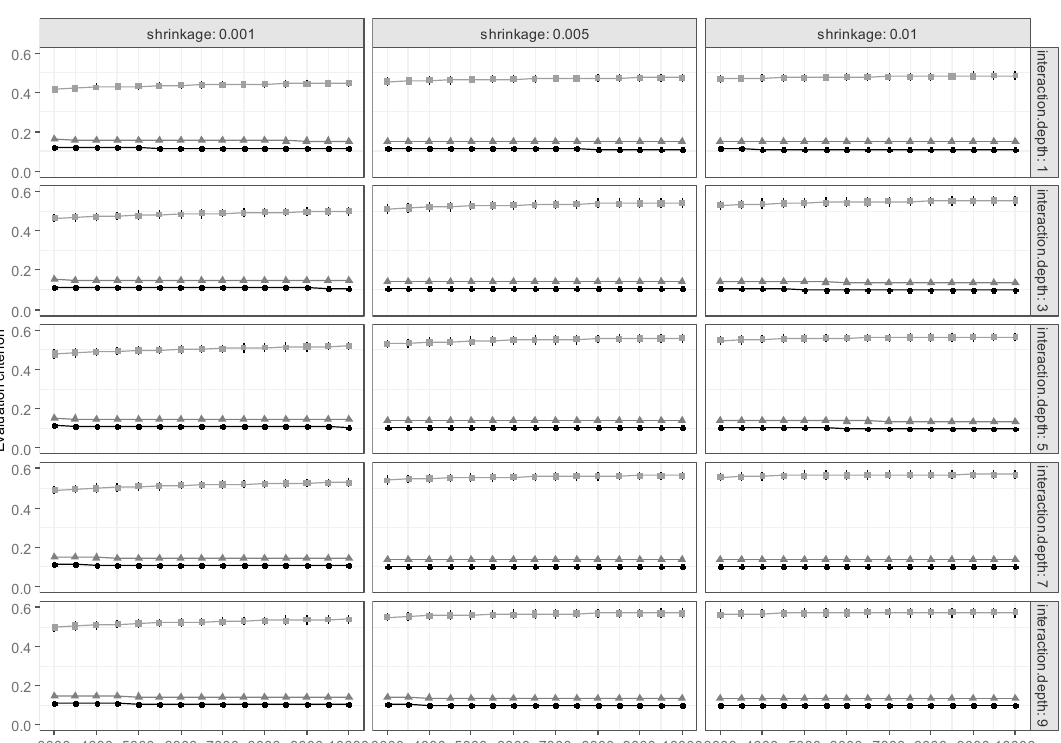
Figure 2. Tuning boosted regression tree (BRT)—the effect of n.trees, shrinkage and interaction.depth on BRT model performance. The tenfold cross-validation was used for validating. The error bar is standard deviation. The parameters, n.trees, shrinkage and interaction.depth are the total number of trees to grow, the step-size reduction or learning rate and the maximum depth of variable interactions for each tree, respectively.